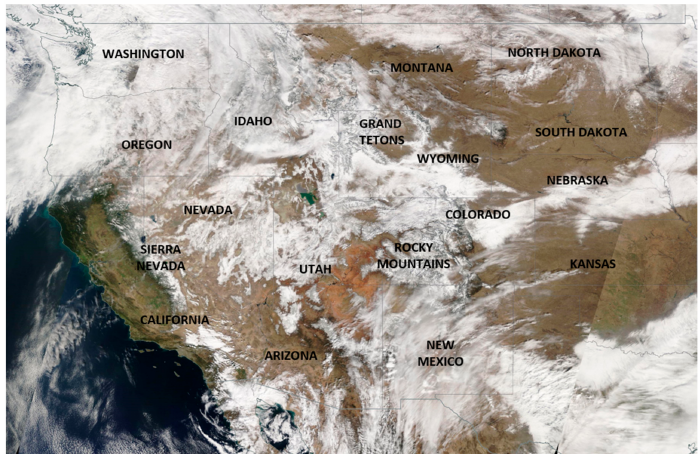
Figure 3. NASA Worldview Terra true color image of the western United States on 16 February 2012. States and geographic features are